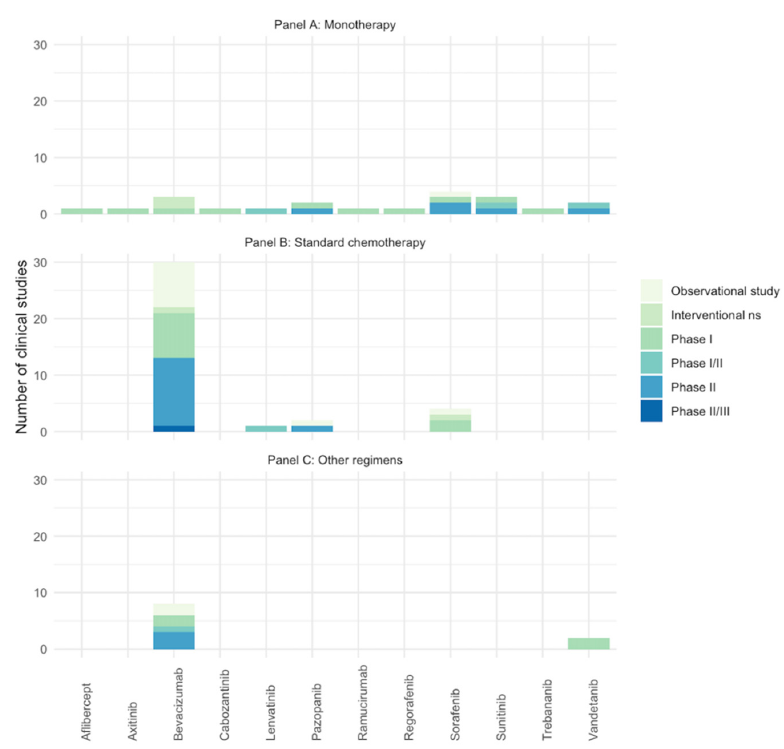
Figure 2. Number of included studies (clinical trials and observational studies) assessing the AEs of anti-angiogenic drugs in pediatric patients with solid tumors. Studies with same NCT identifier were considered as one. ( A ) Anti-angiogenic drugs in monotherapy; ( B ) anti-angiogenic drugs in combination with standard chemotherapy; ( C ) anti-angiogenic drugs in combination with target therapy/other. Ns: phase non-specified.